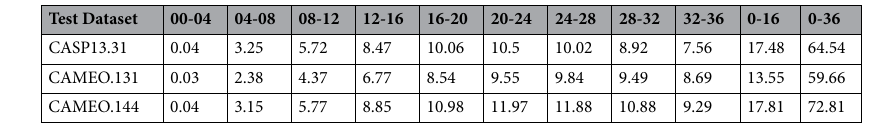
Table 1. Percentages of residue pairs having distances within [ l , h )